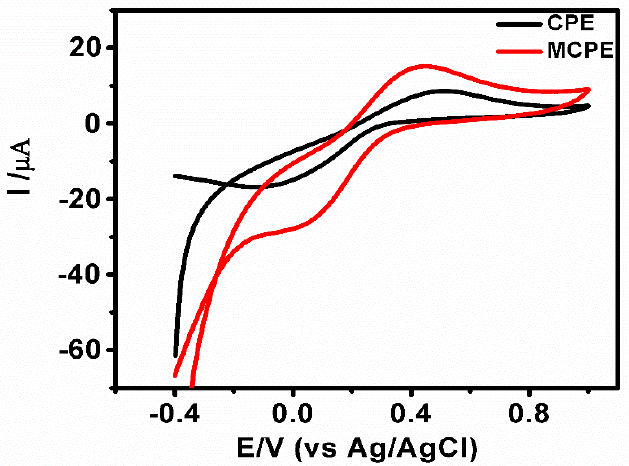
Figure 3. Differential pulse voltammograms ( A – C ) show the determination of the electrochemical behavior of the selected phenolic compounds of 0.9 × 10 −3 M for sinapic, 1.0 × 10 −3 M for syringic, and 0.3 × 10 −3 M for rutin at carbon paste electrode (CPE) and carbon paste mixture prepared with Fe 3 O 4 nanoparticles (MCPE) in 0.5 M ABS with pH 4.8, recorded at 0 V to +1.0 V. The inset cyclic voltammograms ( A – C ) of the selected phenolic compounds at CPE and MCPE was carried out in 0.5 M acetate buffer solutions (ABS) with pH 4.8 and recorded at a scan rate of 0.2 Vs −1 .